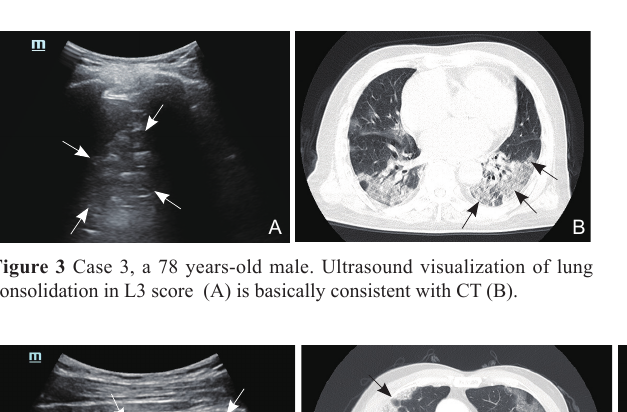
Figure 2 Case 2, a 63 years-old female. Ultrasound observation of lung consolidation in L3 score (A) is basically consistent with CT findings (B and C).